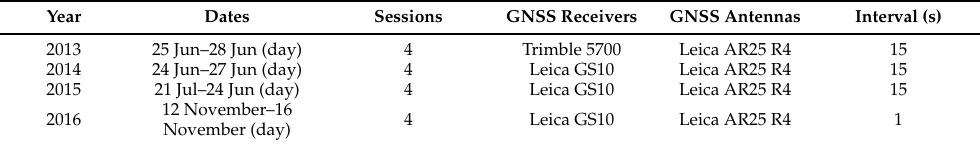
Table 5. GNSS instruments used in every campaign and time interval of data